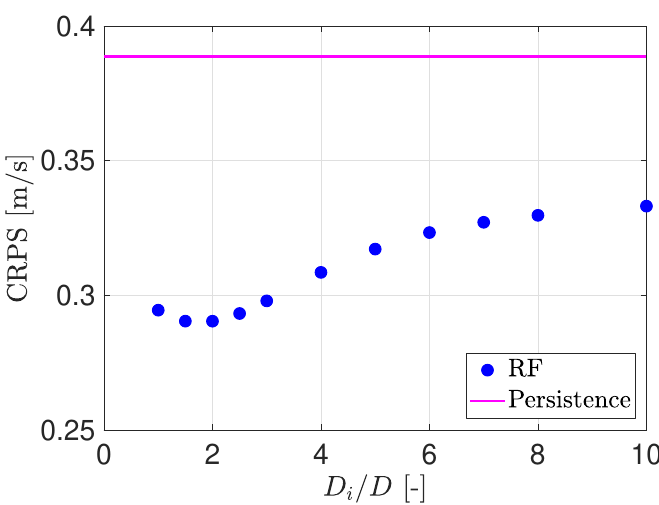
Figure 6. Average continuous ranked probability score (CRPS) for the one-minute ahead wind speed predictive densities for different areas of influence A i with the remote-sensing forecasting (RF) model (blue dots) and for a probabilistic persistence method (magenta line). The area of influence is expressed in number of rotor diameters ( D ).